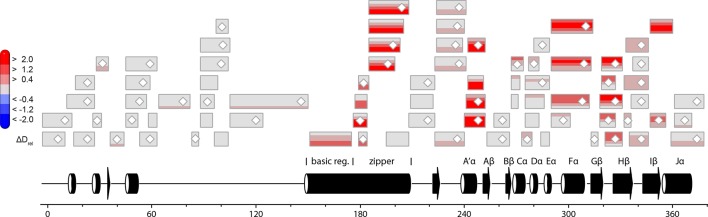
Effect of illumination on PtAu1afull in the absence of DNA.Each box reflects one peptide and contains five different colors that correspond to the differences in relative deuteration (ΔDrel) between light and dark (ΔDrel of PtAu1afull,light - PtAu1afull,dark) experiments according to the legend on the left for the incubation times of 10, 45, 180, 900 and 3600 s (bottom up). MS/MS confirmed peptides are marked with diamonds. Secondary structure elements are taken from DSSP (Kabsch and Sander, 1983) analysis of the PtAu1aLOV dark state crystal structure and PSIPRED (Psi-blast based) secondary structure prediction (Jones, 1999). DSSP, define secondary structure of proteins; MS/MS, tandem mass spectrometry.